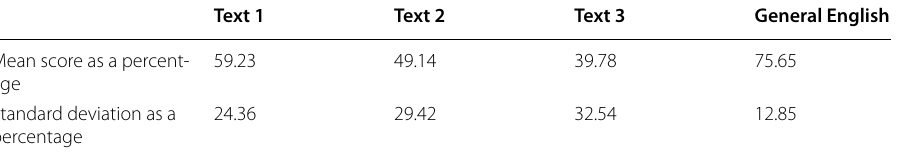
Table 4 Results of the distribution statistics of the scores